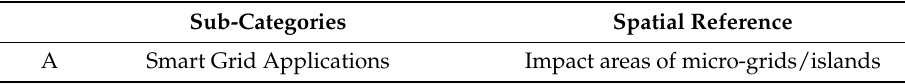
Table 5. Category 5: Virtual infrastructure.